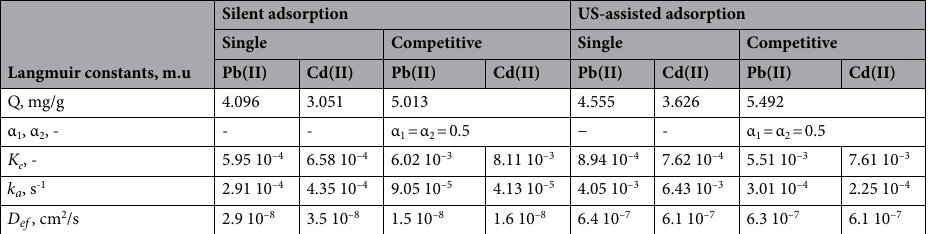
Table 4. Sorption isotherm parameters ( Q , α 1 , α 2 , K e ) and dynamic model parameters ( D ef and k a ) at 25 °C, pH = 5.5 and m HS = 10 g/l.